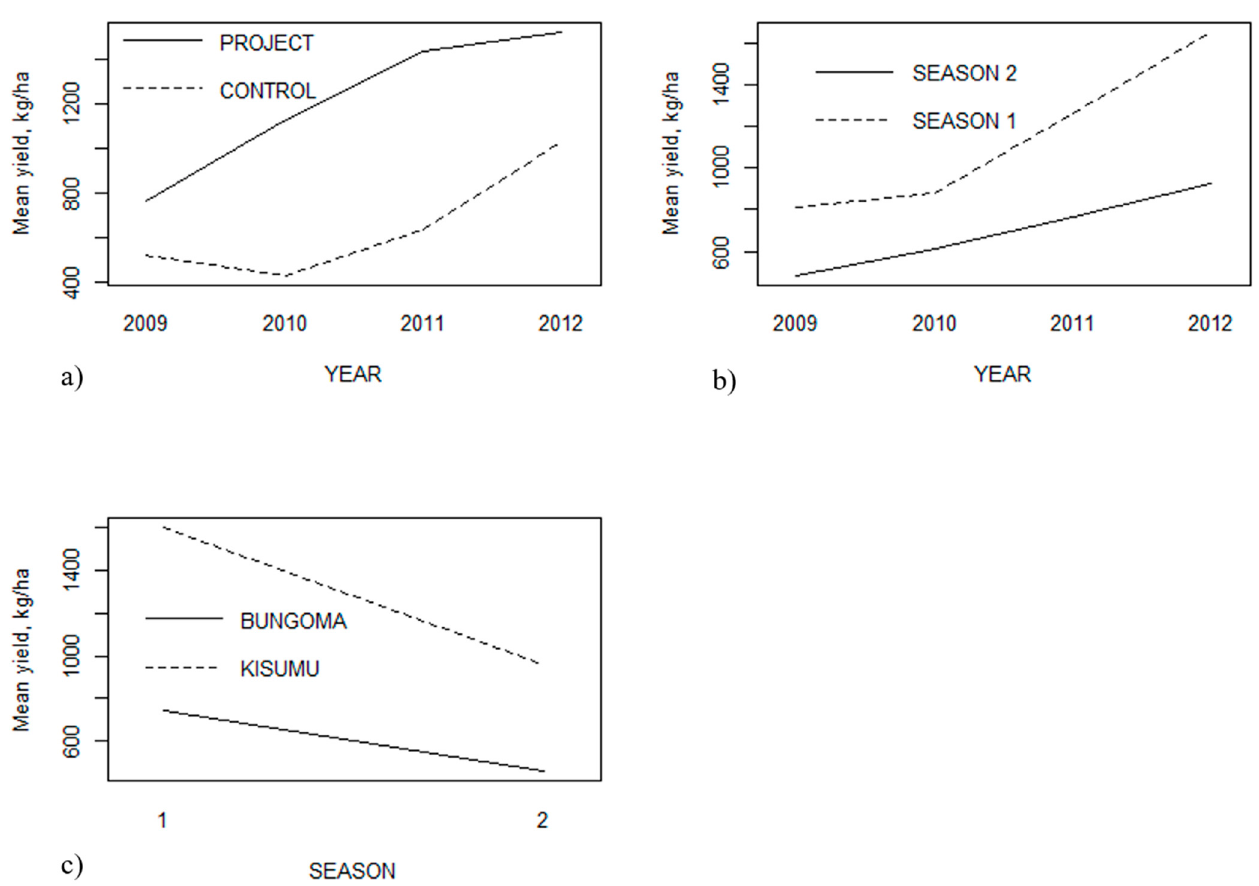
Figure 6. Diagrams showing the three significant interactions identified, between: ( a ) year and treatment ( p < 0.0001), ( b ) year and season ( p = 0.004) and ( c ) region and season ( p = 0.005) on maize yield in kg ha − 1 for project and control farms.